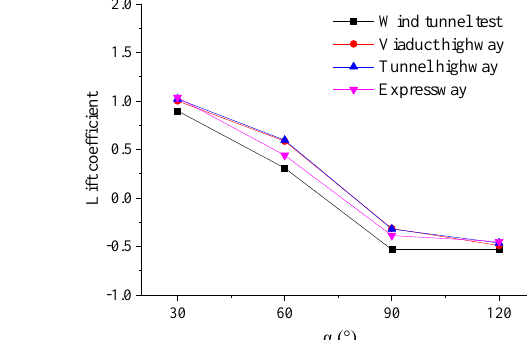
Figure 16. Comparisons of the aerodynamic coefficients of the test model with end plates measured by the wind tunnel test and transiting tests.